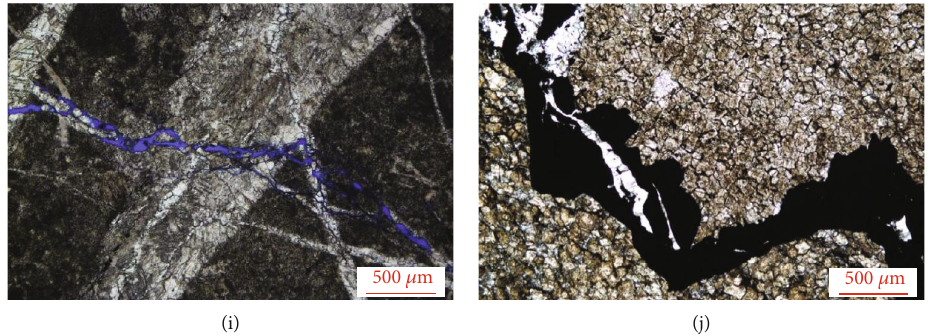
Figure 3: (a) Karst limestone; on top of Member 3 of the Maokou Formation in the HLCH pro fi le. (b) Darkly grey augen limestone; Member 2 of the Maokou Formation in the HLCH pro fi le. (c) Dolomite-bearing bioclastic limestone; Member 2 of the Maokou Formation in the ERY pro fi le. (d) Gravel limestone; Well TL6. (e) Nubby dolomitic limestone; Member 2 of the Maokou Formation in the ERY pro fi le. (f) Paramoudras-bearing bioclastic limestone; Member 2 of the Maokou Formation in the HLCH pro fi le. (g) Fine-grained dolostone; Member 3 of the Maokou Formation in the ERY pro fi le. (h) Reticulate carbonate veins; Member 3 of the Maokou Formation in the HLCH pro fi le. (i) Two phases of carbonate veins in the HLCH pro fi le. (j) Residual hydrocarbons in carbonate veins; Well